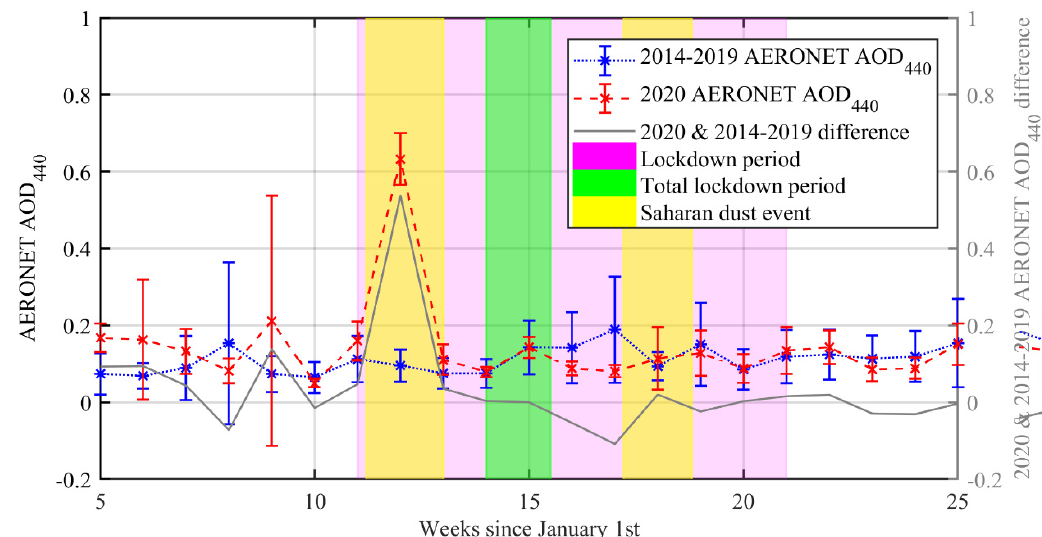
Figure 4. AERONET AOD at 440 nm temporal evolution. Blue line stands for 6-year weekly AERONET AOD 440 average (from 2014 to 2019). Red line stands for AERONET AOD 440 weekly mean values in 2020. Gray line represents the difference between both lines; negative values point out lower AOD 440 during 2020 compared to AOD 440 values found in previous years. Colored areas stand for Saharan dust events, lockdown period and total lockdown period during 2020 in yellow, pink and green, respectively. Errors have been estimated using standard deviation. Only Saharan dust outbreaks during the lockdown period are shown.